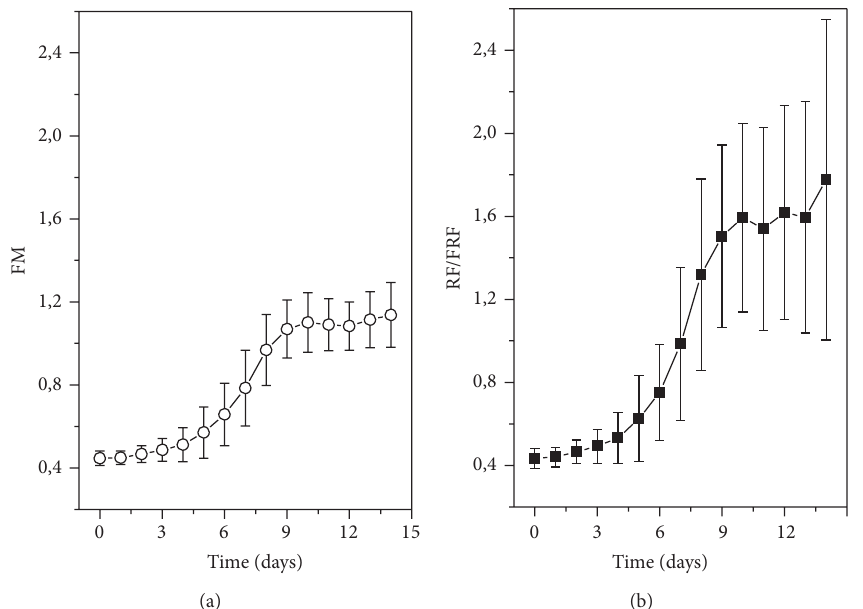
Figure 1: (a) Figure of merit (FM) and (b) RF/FRF ratio as a function of time after detachment for the LIF experiment.